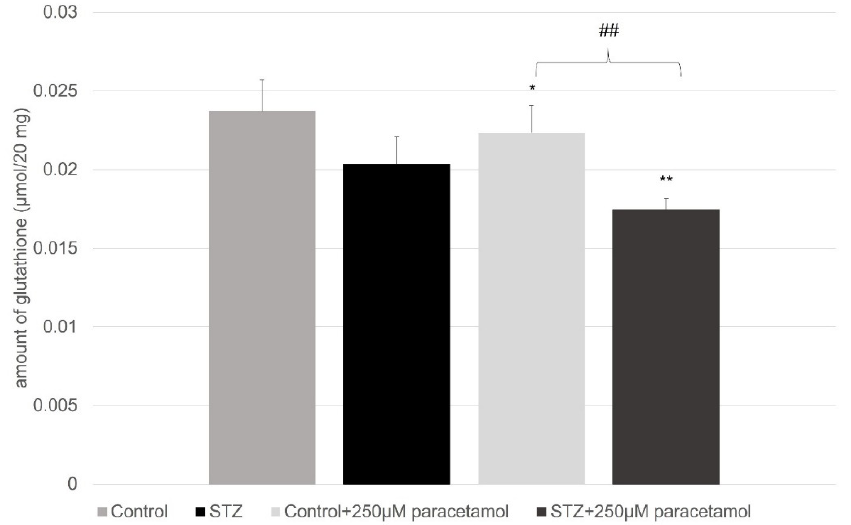
Figure 5. Amount of glutathione ( μ mol/20 mg) in the small intestine without and with paracetamol perfusion in case of control and diabetic rats. Values represent the mean ± S.E. of five rats. Each value represents the mean of 5 independent experiments ± standard error. *, p < 0.05; **, p < 0.01, ## , p < 0.01 versus control.